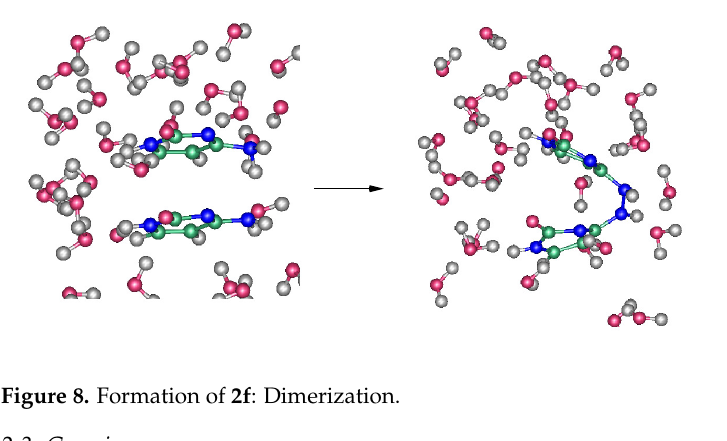
Figure 8. Formation of 2f :